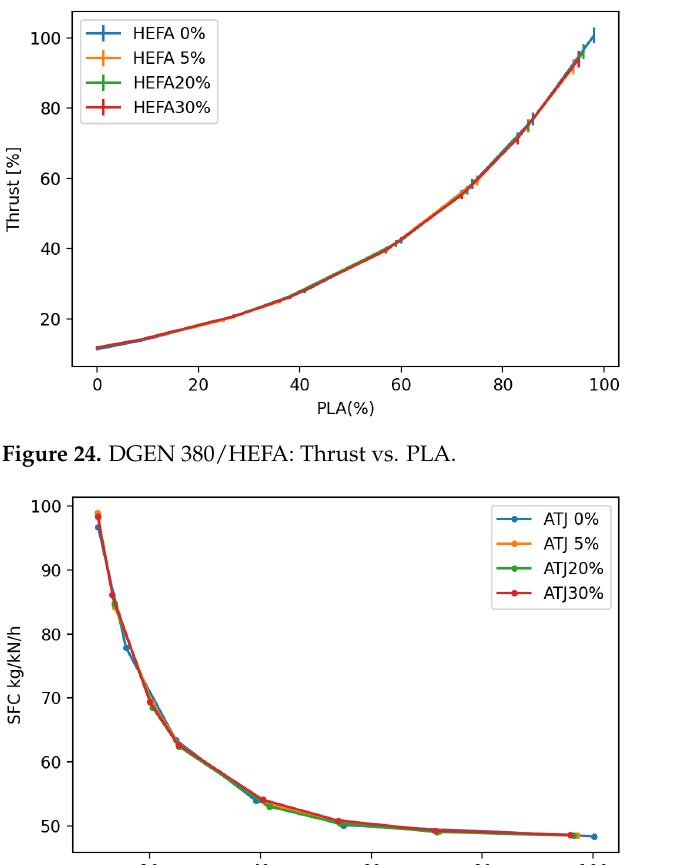
Figure 23. DGEN 380/ATJ: Thrust vs. PLA.